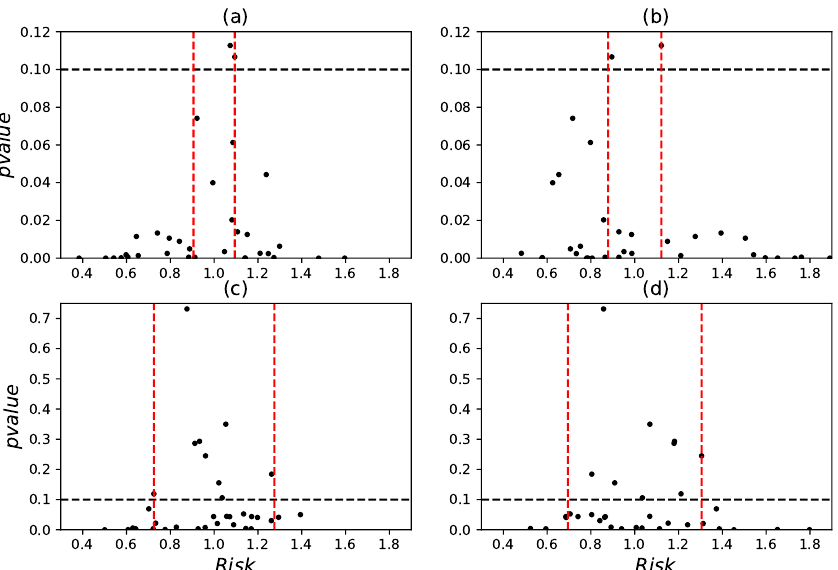
Figure A2. p -value resulting from the 2 dimensional Kolmogorov-Smirnov test performed between the climatological sample and the seasonal samples as a function of the real computed risk measure normalized by climatology. Black dashed line represents the 10% significance level for which the hypothesis of 2 samples coming from the same distribution cannot be rejected; Red dashed lines represent the threshold defined; ( a ) for winter and risk of high consumption and low production R c + p − , ( b ) for winter and risk of low consumption and high production R c − p + , ( c ) for fall and risk of high consumption and low production R c + p − , ( d ) for fall and risk of low consumption and high production R c − p +